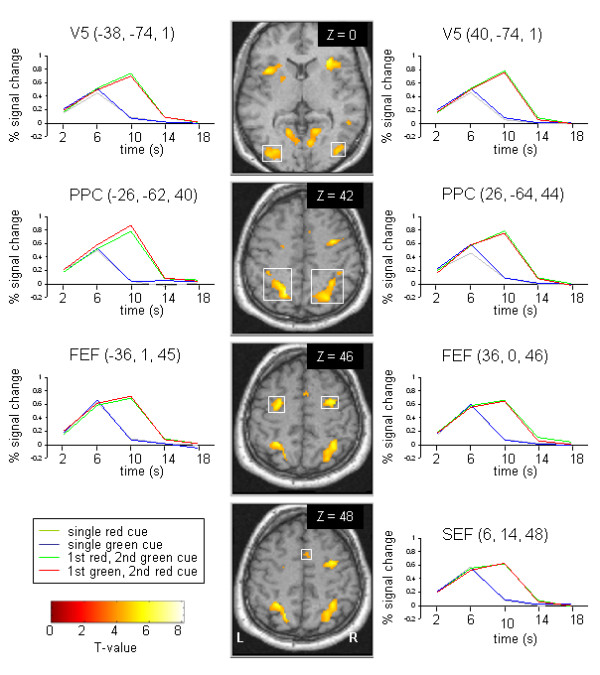
Percent signal change against time for significant activated regions. The time courses were aligned to the onset of the first cue and averaged across subjects. Talairach coordinates are given. The gray and blue lines indicate the conditions consisting of the red and green cue, respectively. The green line represents the sequence of first red then green cue, the red line represents the sequence of first green then red cue. PPC = posterior parietal cortex, FEF = frontal eye field, SEF = supplementary eye field, L = left hemisphere, R = right hemisphere.